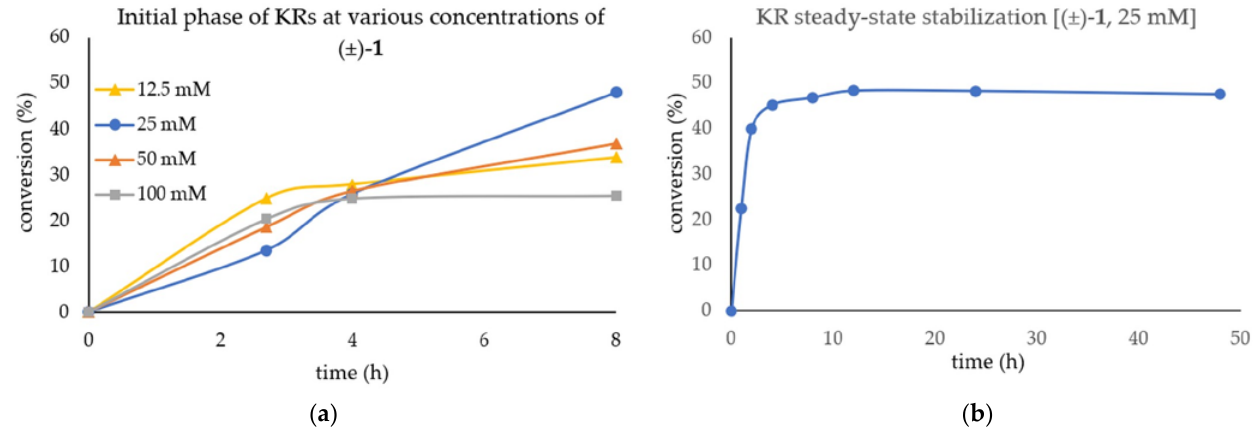
Figure 5. Use of the U-shape reactor charged with CaLB-MNP C15 (5 mg) for continuous flow mode kinetic resolution of racemic 4-(morpholin-4-yl)butan-2-ol (±)- 1 ((±)- 1 (varied concentrations), vinyl acetate (2.5 equiv.), MTBE:hexane 1:2, 25 °C, 1 μL min −1 ). The ( a ) initial stabilization phase at various concentrations of (±)-1 (12.5–100 mM) and ( b ) the time course of steady-state stabilization at 25 mM substrate concentration in the U-shape reactor are shown. The CaLB-MNP C15 charged reactor used in ( a ) the concentration dependence investigations was recovered and applied in ( b ) the steady-state stabilization study.